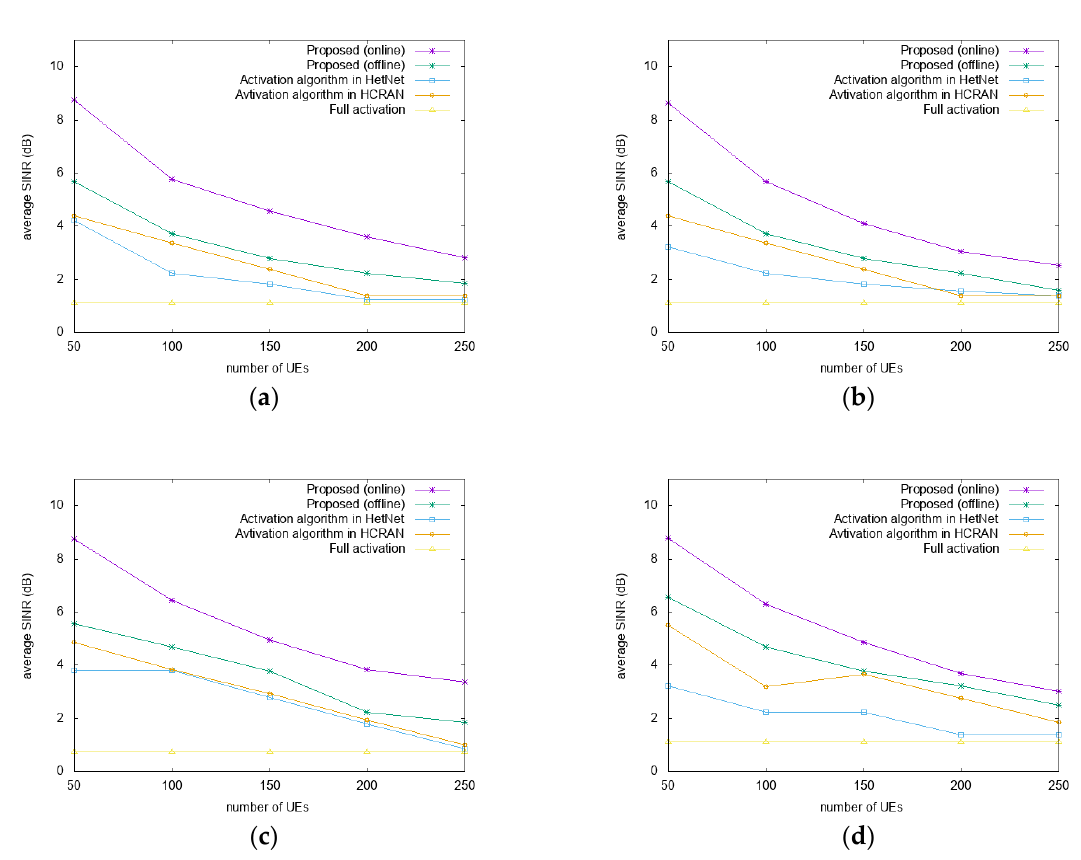
Figure 3. Comparison of the average SINRs. ( a ) San Francisco and ( c ) Beijing datasets with Gaussian distributions; ( b ) San Francisco and ( d ) Beijing datasets with uniform distributions.